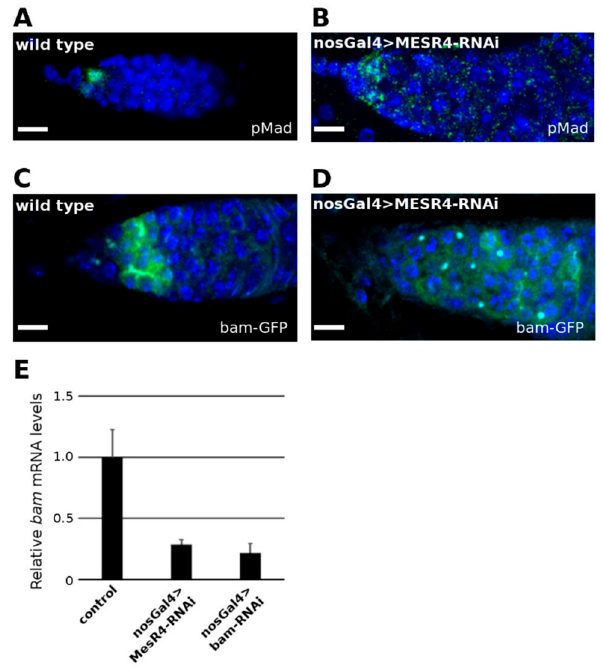
Figure 2. MESR4 promotes bam expression in the GSC daughter cells. ( A , B ) Wild type control ( A ) and nosGal4 > MESR4 -RNAi niches ( B ) stained with pMad (green) and DAPI (blue). Germline-depleted MESR4 niches do not accumulate pMad positive cells. Scale bars: 10 µ m. ( C , D ) Wild type control ( C ) and nosGal4 > MESR4 -RNAi niches ( D ) expressing GFP under the control of the bam promoter. Niches were stained with GFP (green), and DAPI (blue). In the germline depleted MESR4 niches there are less GFP signals. Scale bars: 10 µm. ( E ) Quantitation of steady state bam mRNA levels in bgcn 1 /Df(2R)BSC136 control, nosGal4 > MESR4 -RNAi and nosGal4 > bam -RNAi ovaries. Compared to the control (1.0 ± 0.2), bam mRNA levels are decreased in the MESR4 silenced (0.28 ± 0.03) and bam silenced (0.22 ± 0.07) ovaries.